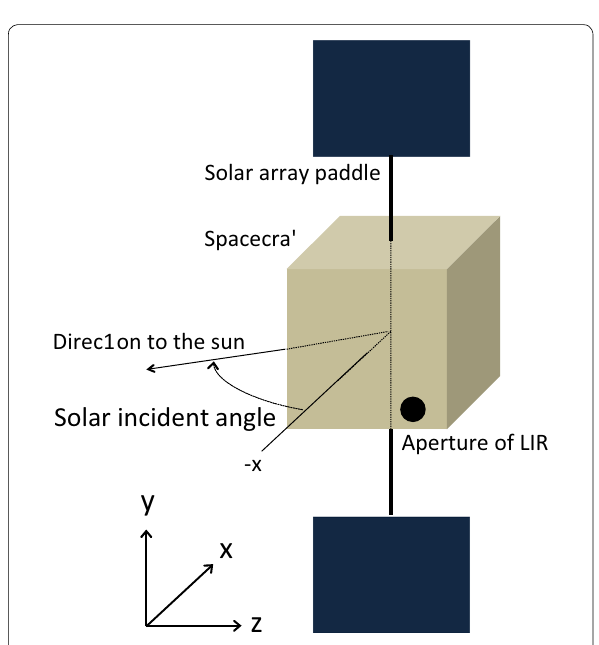
Fig. 4 Orientation of LIR aperture and solar incident angle between the direction to the sun and the ‑ x ‑axis of the spacecraft. The space‑ craft basically orients its the ‑ x ‑plane toward Venus except when it communicates with the ground station on the Earth (Nakamura et al. 2007). The solar incident angle at observation depends on the orbit